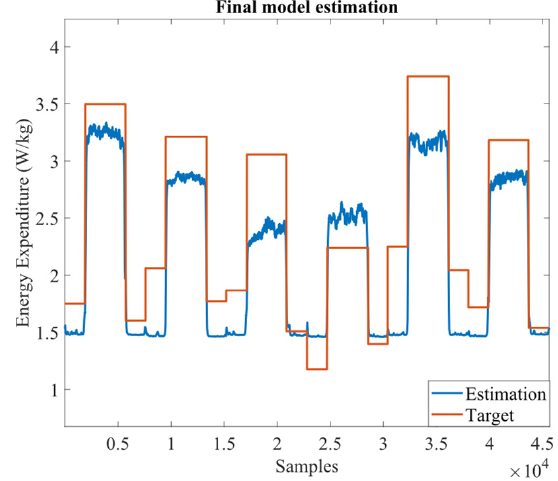
Figure 6. CNN estimation for the novel subject.